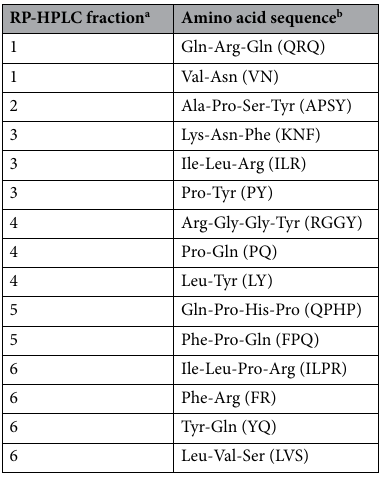
Table 4. Synthesis of 15 preferred peptides. a Fractions are indicated in Fig. 3 b Three-letter representations of amino acids and single-letter representations in parentheses.